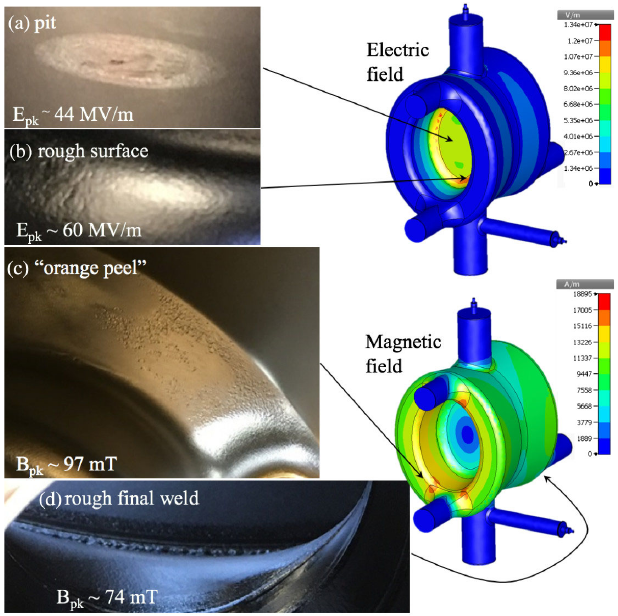
FIG. 9. Surface features found in the rf surface of cavity 1 after bulk BCP. Field values correspond to the quench voltage (5.9 MV).